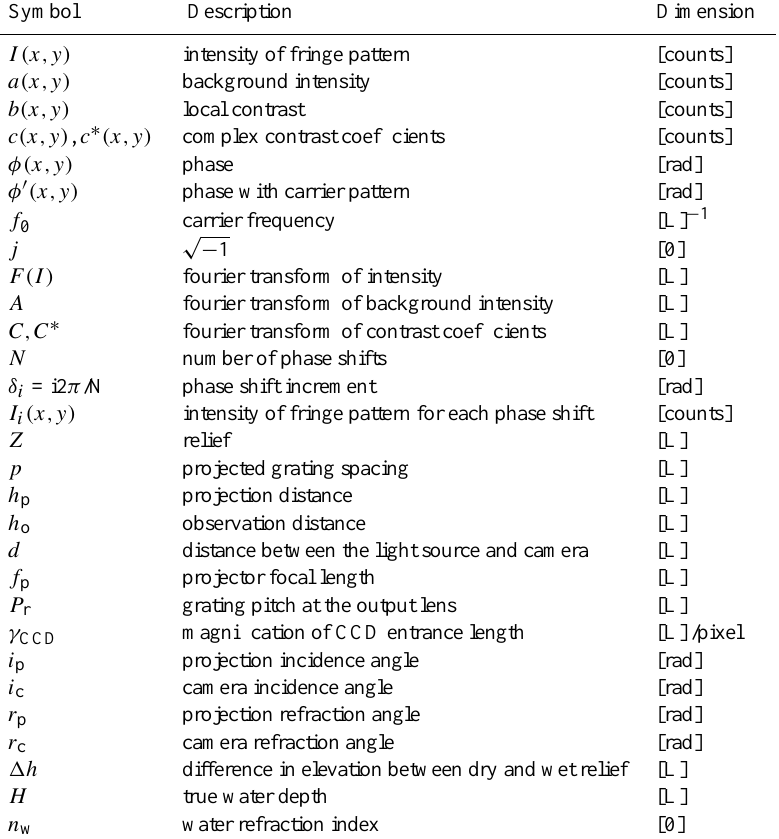
Table 1. Symbols and notations used in this paper